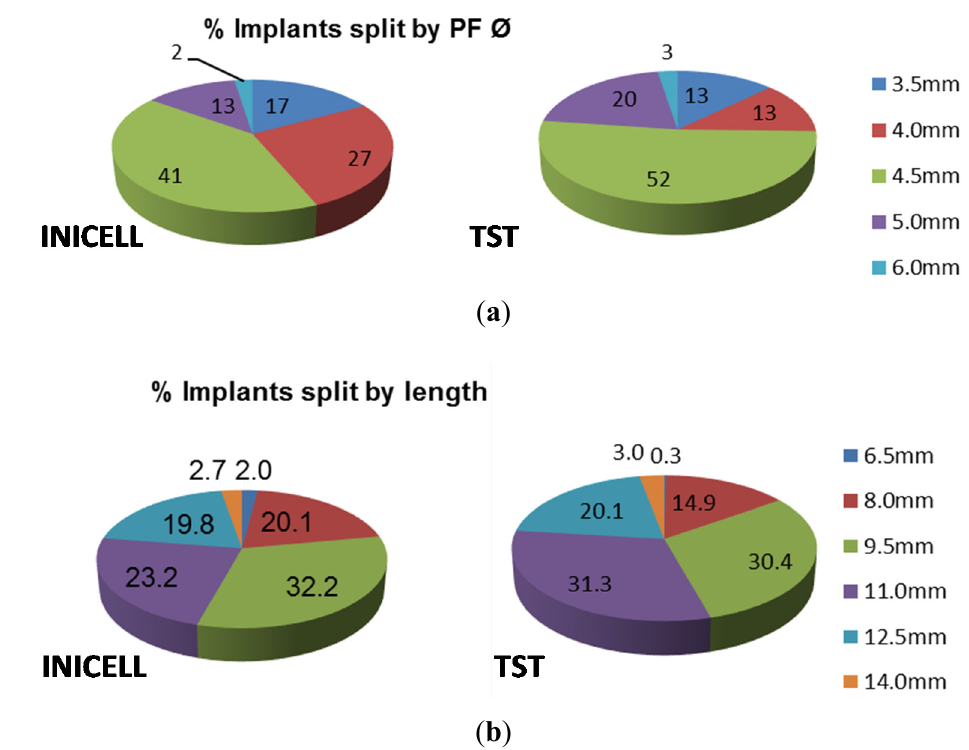
Figure 3. Overview of used implants by ( a ) diameter and ( b )